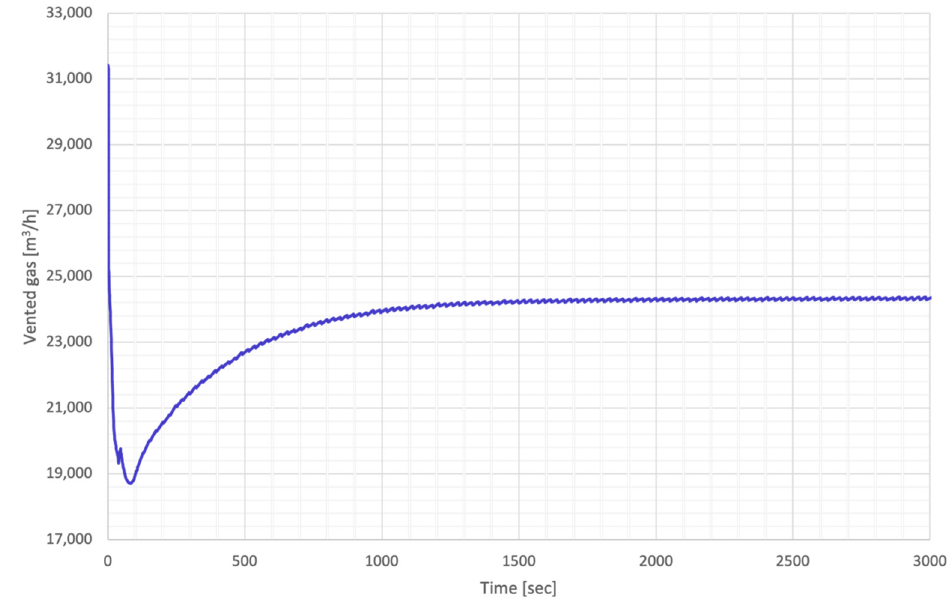
Figure 8. Actual volumetric gas flow vented by 32 inches piping.